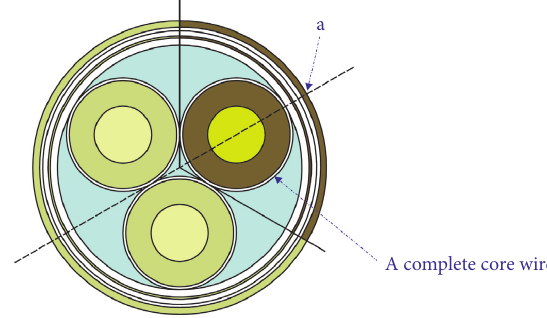
Figure 6: Schematic diagram of trisection of cable radial section.